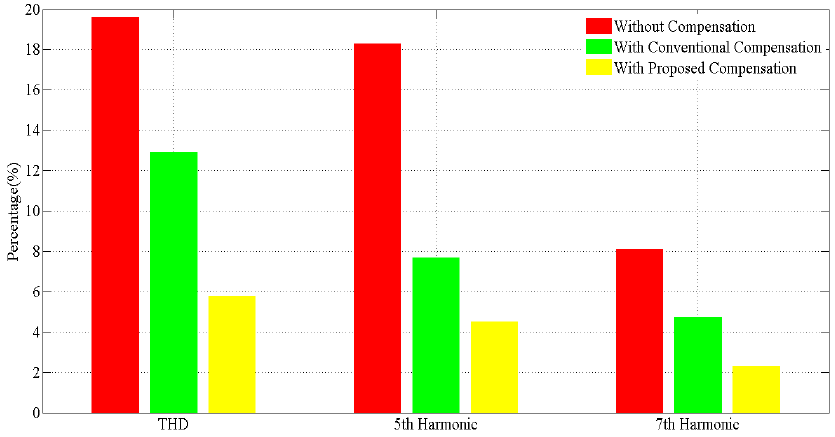
Figure 13. The comparison of the experimental harmonic components.